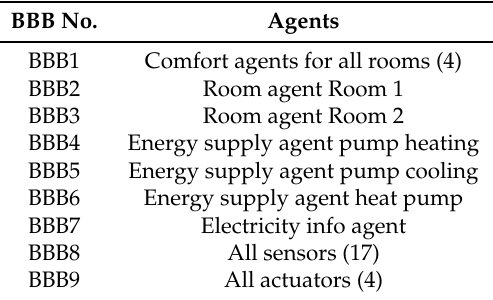
Table 2. Deployment on BBB.